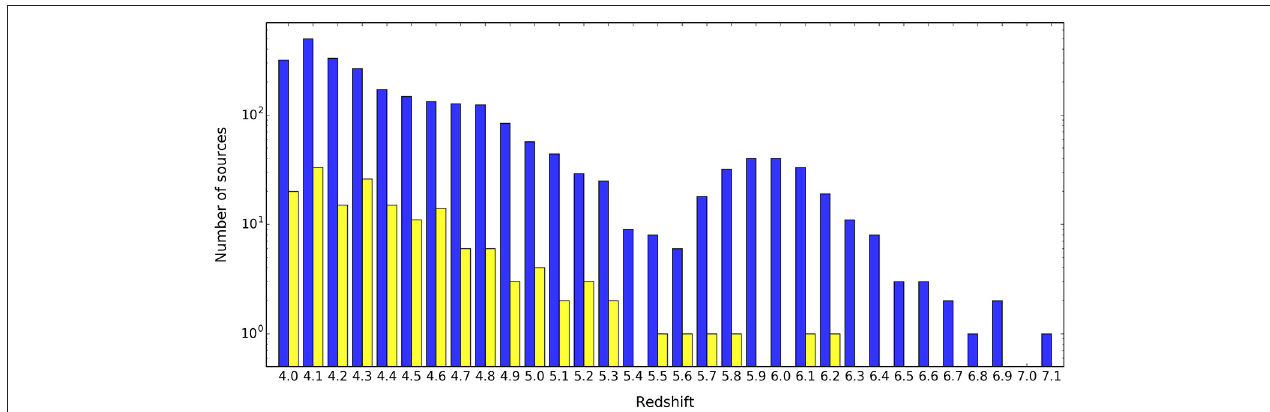
FIGURE 2 | Histogram of the redshift distribution of catalog entries, with a bin width of 0.1. Blue columns indicate all AGN in the sample, while yellow columns show the distribution of sources with available radio flux densities. From the total of 2,591 sources, 166 are detected in FIRST or (if out of FIRST coverage) in NVSS. Two thousand one hundred and forty-eight positions are covered by FIRST but radio sources not detected (brightness upper limit is available only). Two hundred and fifty two sources are outside the FIRST field and lack detection in NVSS, and 25 are outside the footprints of both surveys.